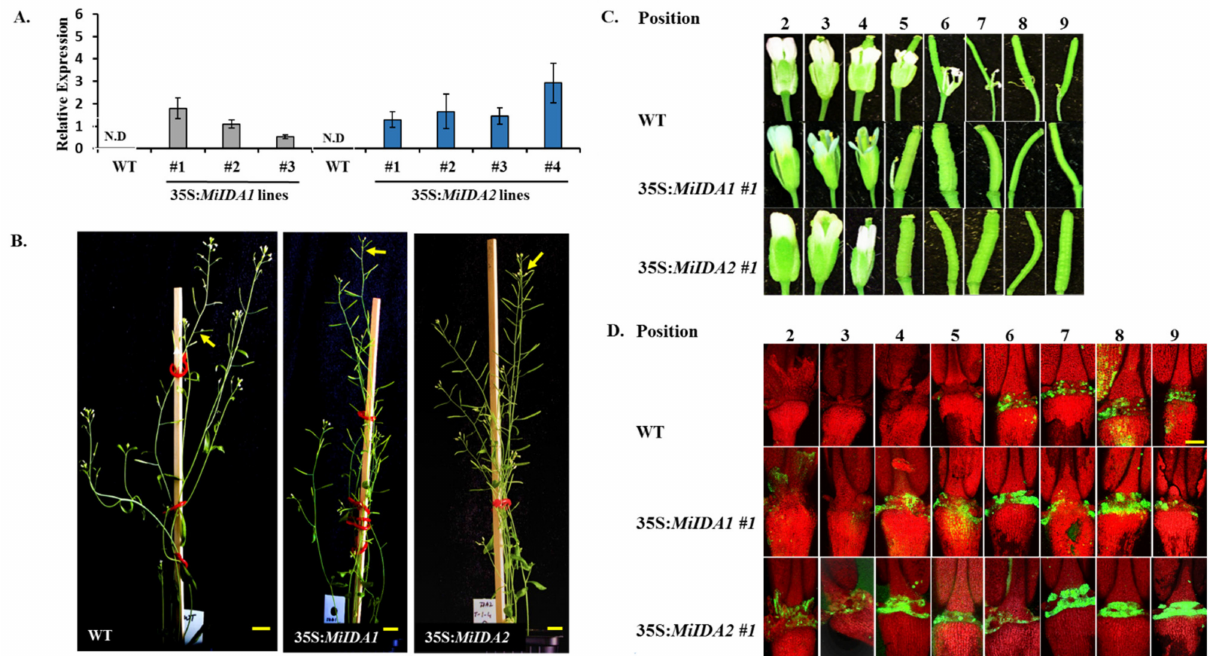
Figure 6. Ectopic expression of MiIDA1 and MiIDA2 in Arabidopsis promotes early floral organ abscission. ( A ) Relative expression levels of MiIDA1 (grey columns) and MiIDA2 (blue columns) in WT, 35S: MiIDA1 , and 35S: MiIDA2 transgenic Arabidopsis plants. Values represent relative expression levels normalized against the AtACT gene, and the data are presented as means + SE of four replicates per line. ND, not detected. ( B ) Phenotype comparison of Arabidopsis Col-0 (WT) and two representative overexpressing 35S: MiIDA1 and 35S: MiIDA2 lines. Scale bar = 1 cm. Arrows denote attached floral parts. ( C ) Phenotypes of floral organ abscission in Arabidopsis Col-0 (WT) and in 35S: MiIDA1- and 35S: MiIDA2 - overexpressing plants. Flowers and siliques from different positions along the inflorescences were sampled separately from WT, and the 35S: MiIDA1 and 35S: MiIDA2 lines. Flower position numbers are indicated starting from the second flower at anthesis. The images presented for each WT plant or overexpressing lines are representative images of 3 or 4 replicates. ( D ) Representative BCECF fluorescence micrographs of floral organ AZs of Arabidopsis Col-0 (WT), and 35S: MiIDA1 and 35S: MiIDA2 plants. Intact flowers and siliques were sampled separately, incubated in BCECF solution, and examined with a confocal laser scanning microscope. Images represent merged images of BCECF fluorescence with chlorophyll auto-fluorescence images. The green color represents the increase in pH (detected by increased BCECF fluorescence), and the red color represents chlorophyll auto-fluorescence. Flower position numbers are indicated, starting from the second flower at anthesis. Scale bar = 200 µ m. The images presented for each WT plant or overexpression line are representative images from 3 or 4